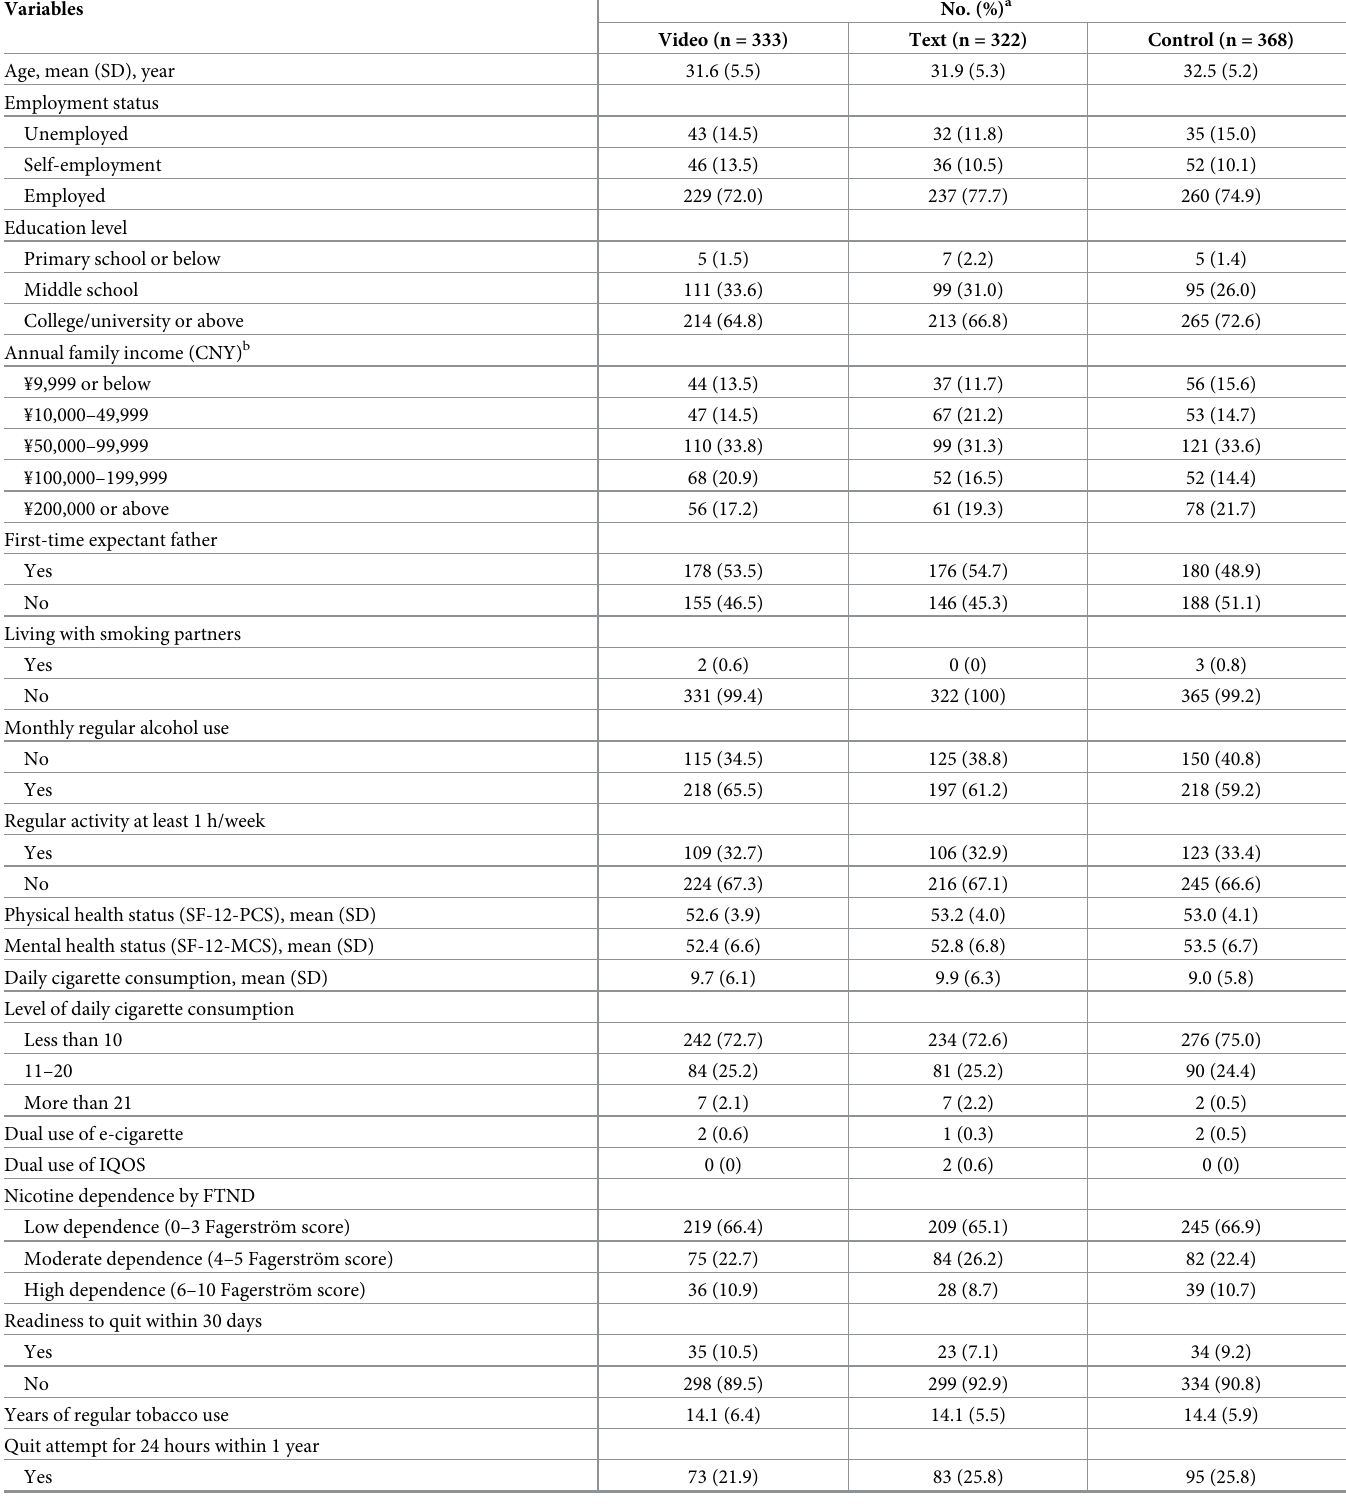
Table 1. Participants’ baseline demographic characteristics and smoking